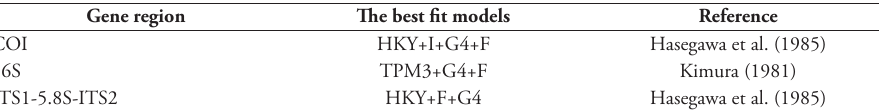
Table 2. The best evolutionary models of ML phylogenomic tree.